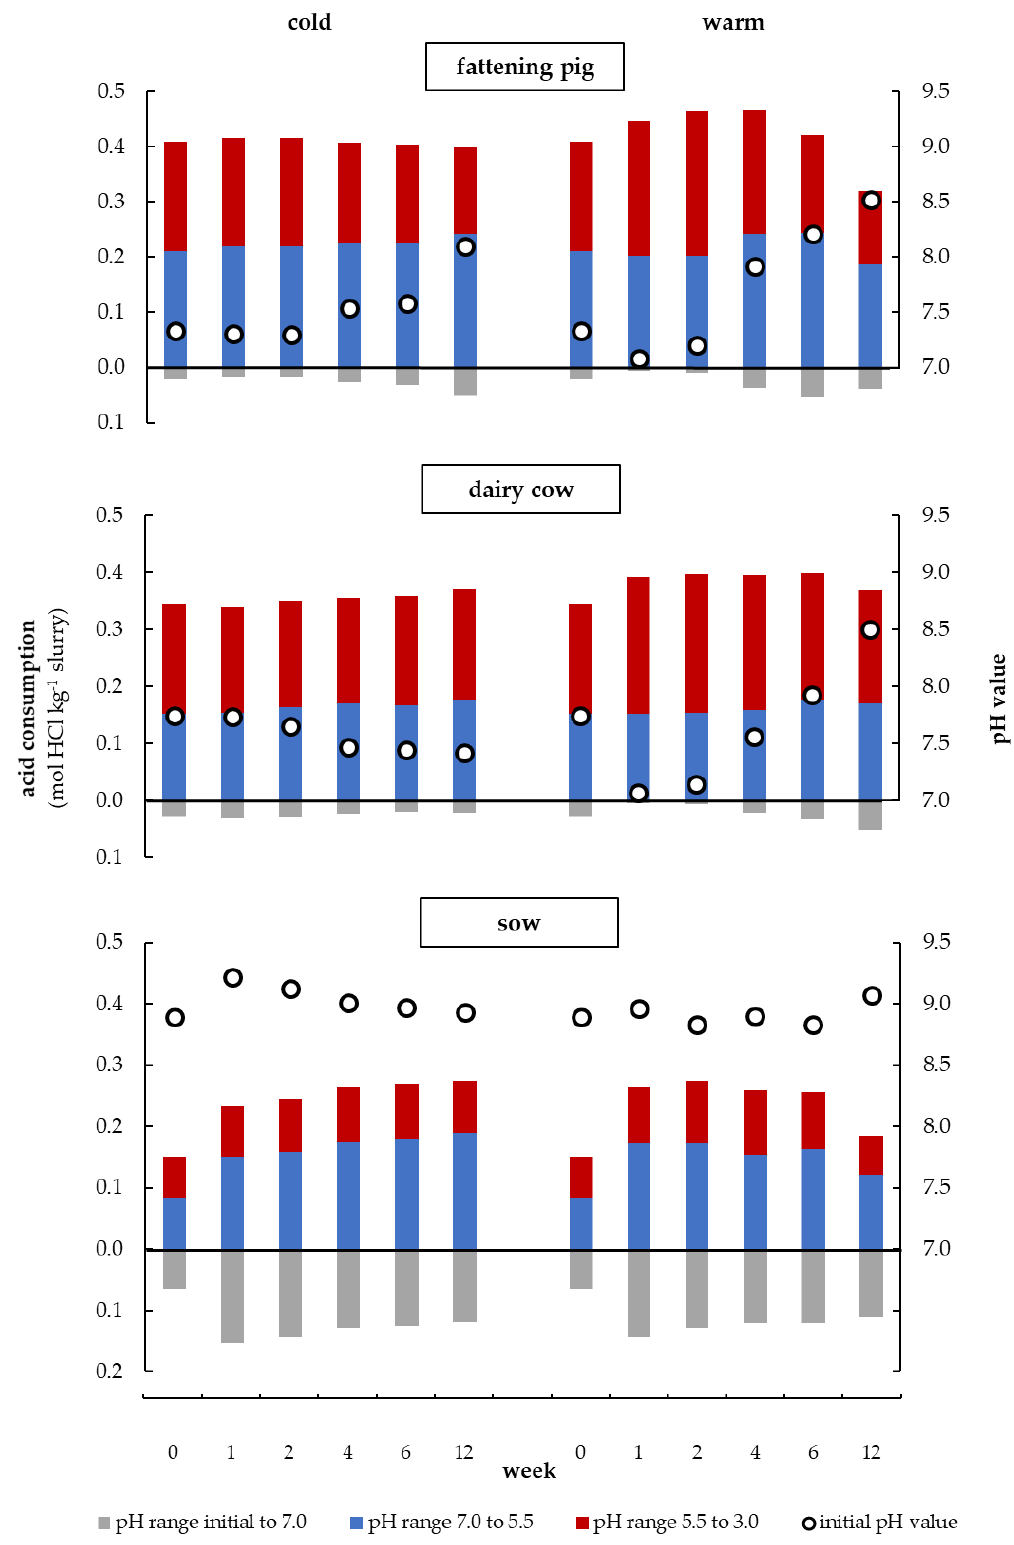
Figure 7. Initial pH value of fattening pig, dairy cow and sow slurry as well as the amount of acid under cold (4.7 ± 1.1 ◦ C) and warm (23.6 ± 2.1 ◦ C) storage conditions in the pH range initial to 7.0, 7.0 to 5.5 and 5.5 to 3.0 over a storage period of 12 weeks; for better visualization, the amount of acid in the pH range initial to 7.0 is shown below the black line.